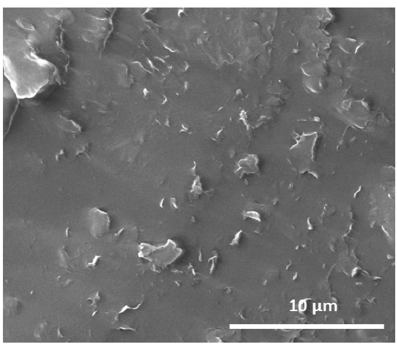
Figure 3. Cross-section SEM images of the graphene nanoplates@natural rubber latex composite.